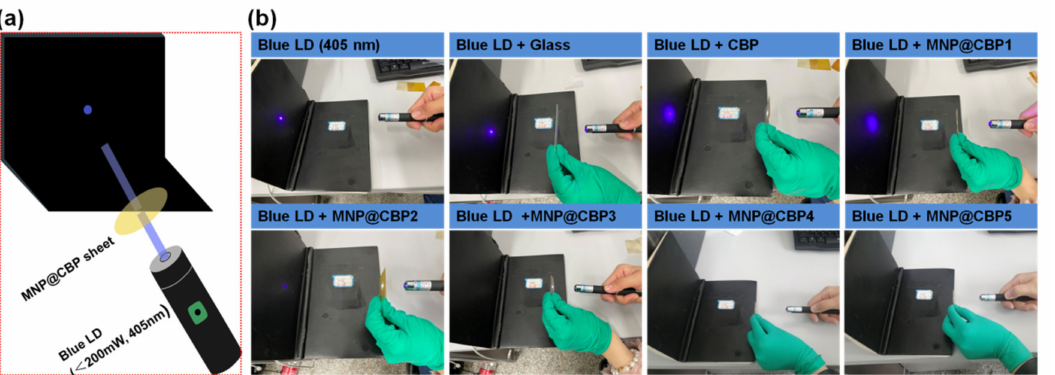
Figure 9. ( a ) Scheme of the experimental setup, ( b ) photographs of blue LD and its blocking effect covered by glass, CBP and